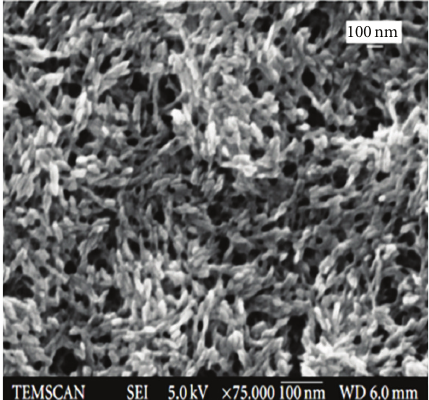
Figure 3: AFM 2D images of PVP capped copper nanobuds. The height of the single nanobud is 6.41nm as measured in noncontact mode.